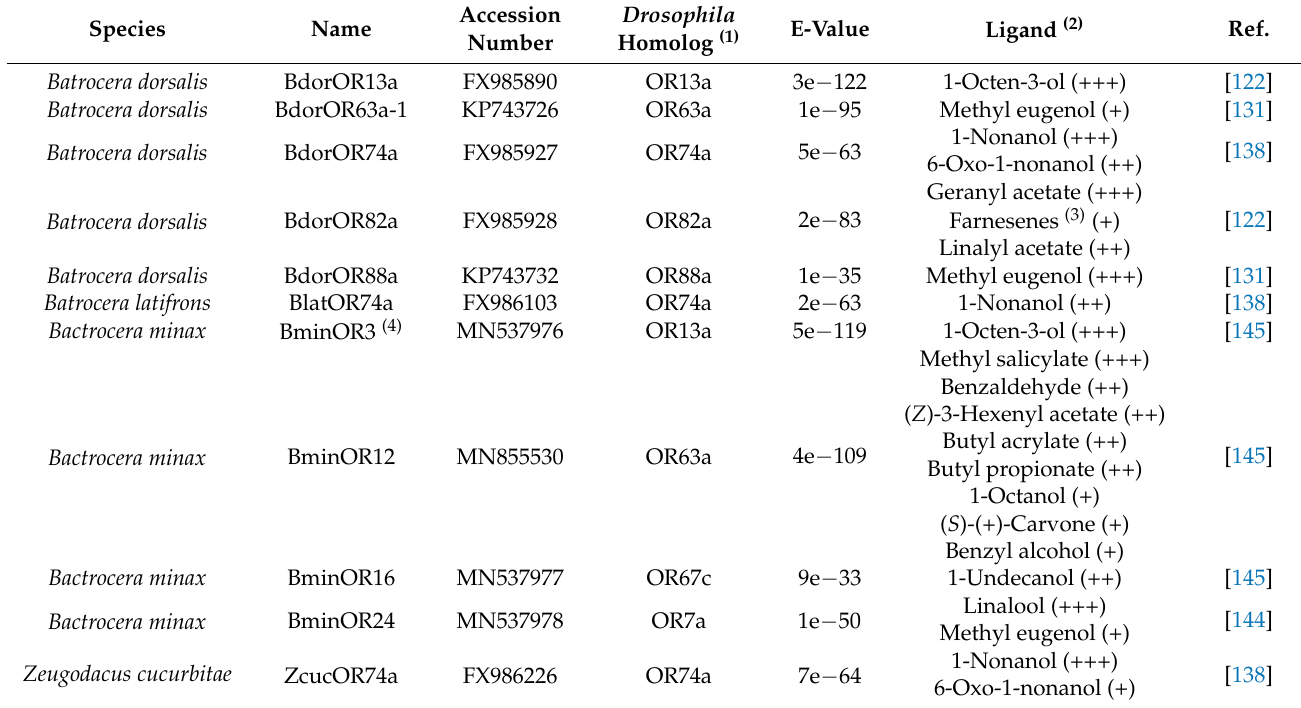
Table 2. Olfactory receptors that respond to semiochemicals in Dacini fruit